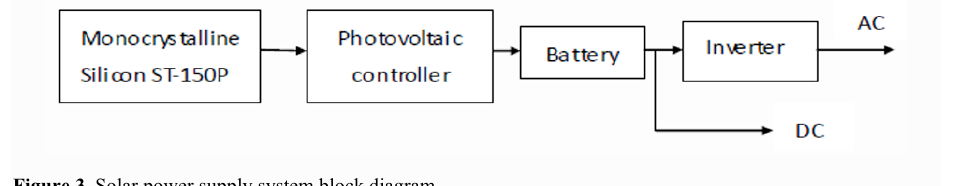
Figure 3. Solar power supply system block diagram